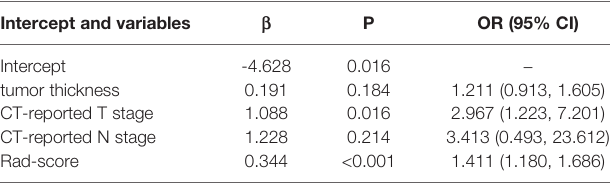
TABLE 2 | Multivariate logistic regression analysis of Clinical and radiomics features between HER2 status with AEG patients in the training cohort. Intercept and variables